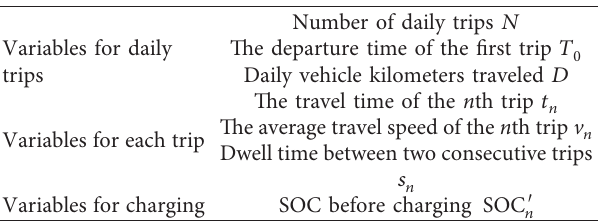
Table 1: A summary of the behavioral variables of the daily trip